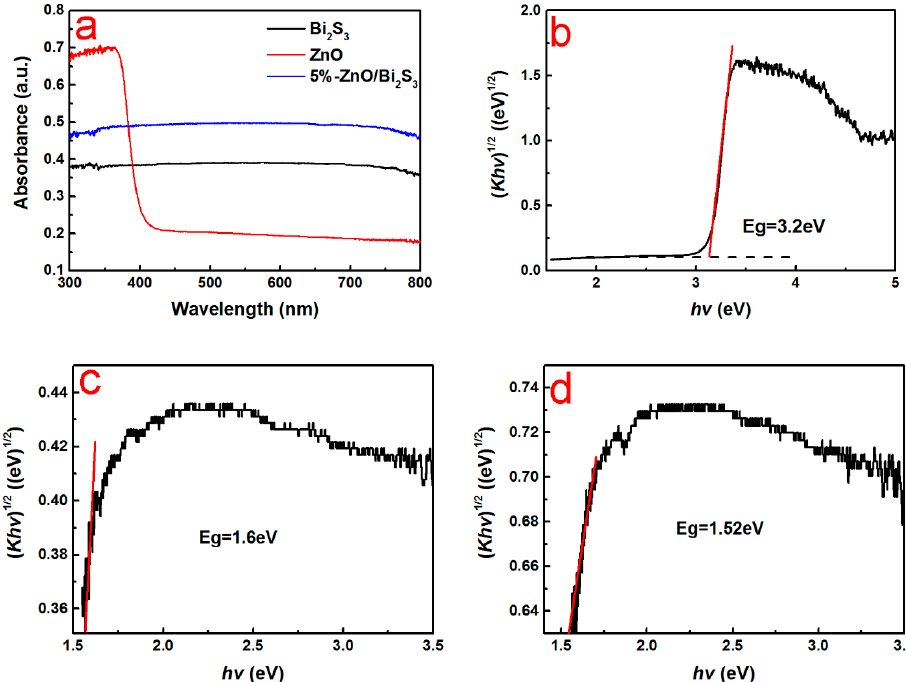
Figure 5. ( a ) UV-Vis spectra of ZnO, Bi 2 S 3 , 5%-ZnO / Bi 2 S 3 composite; ( b – d ) plots of ( khv ) 1 / 2 versus hv of ZnO, Bi 2 S 3 , and 5%-ZnO / Bi 2 S 3 composite.